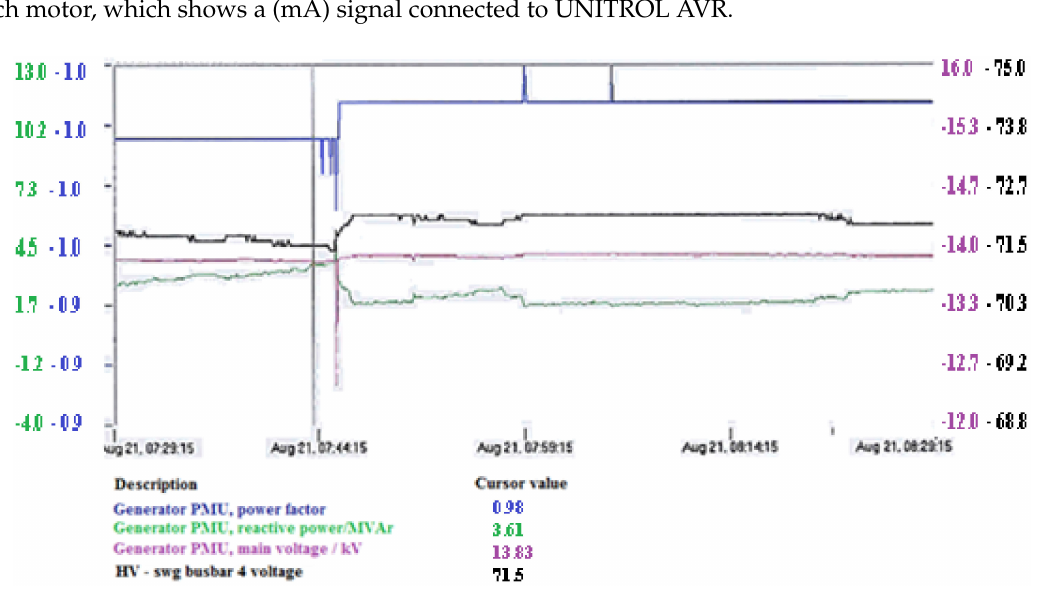
Figure 2. Voltage control does not meet contract,